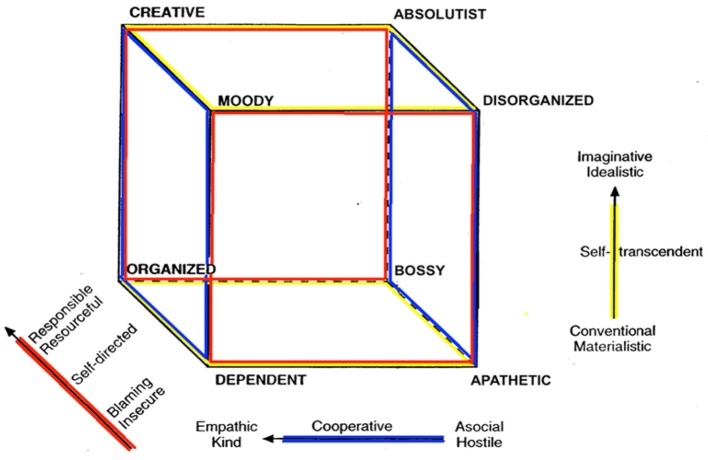
The Character Cube (Cloninger et al., 1993).